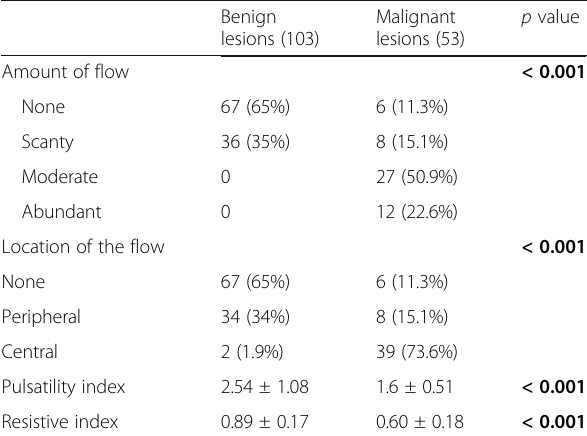
Benign lesions (103)